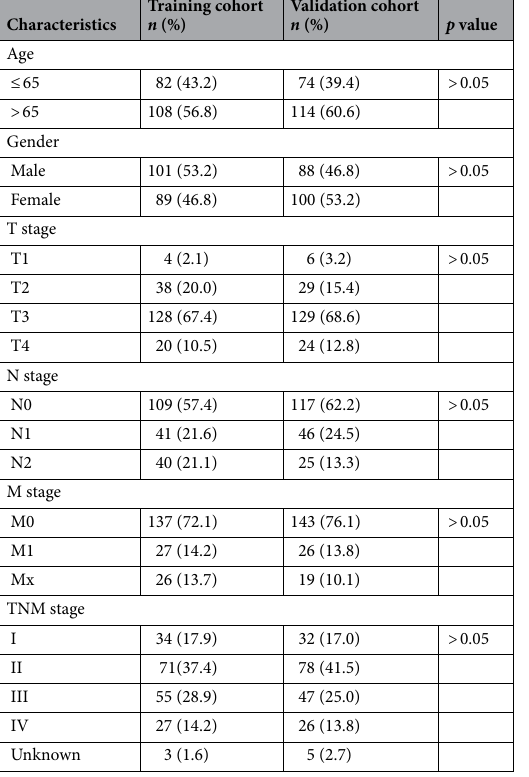
Table 1. Comparison of clinical characteristics between the different